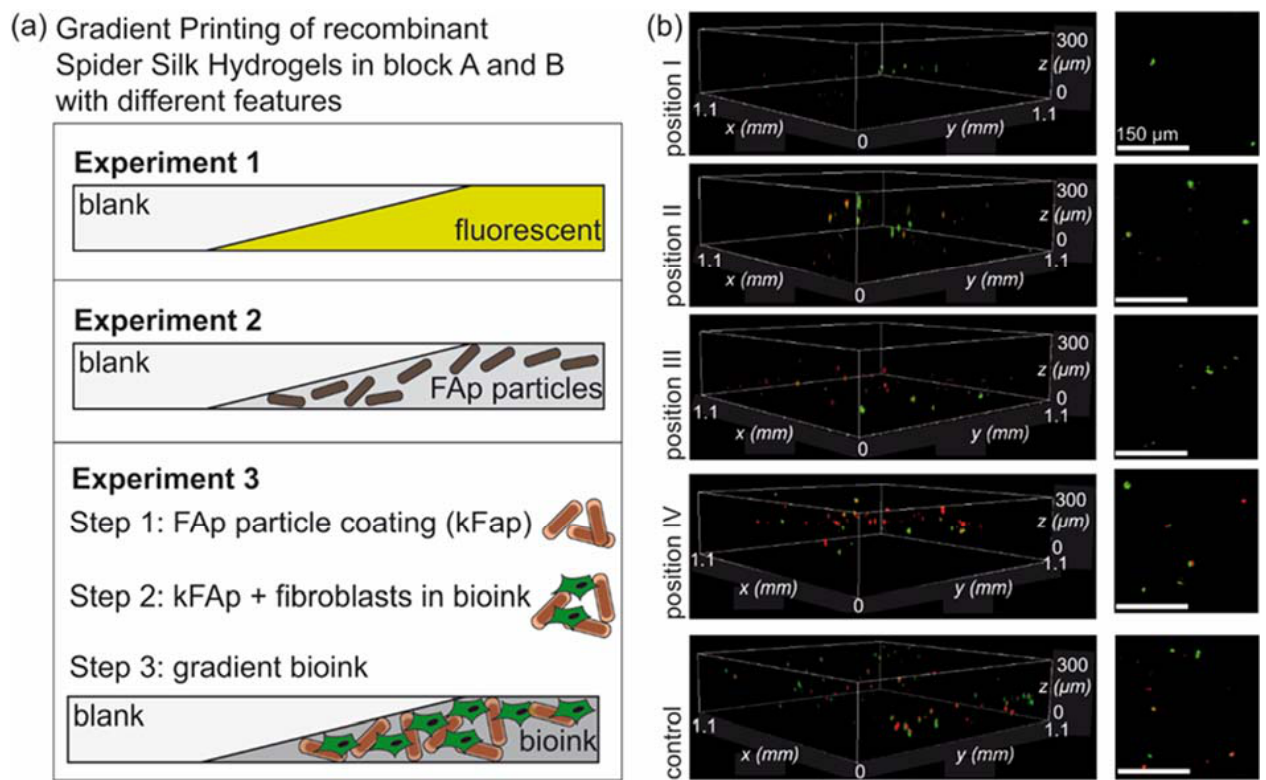
Figure 5. ( a ) Scheme of different experimental set-ups for gradient printing from one printer cartridge with different features. ( b ) Confocal laser scanning microscopy images of fluorescently labeled BALB/3T3 fibroblasts using ethidium homodimer I (red: dead cells)/calcein AM (green: living cells) staining. Cells and 1% w / v κ FAp particles were loaded into a hydrogel and gradient-printed towards an unloaded hydrogel (both hydrogels 3% w / v eADF4(C16)); position I with lowest and position III with highest concentration of cells/particles. Static cell and particle-loaded hydrogels served as control. Left: side view, right: top view. Scale bars right row 150 µ m. κ FAp refers to FAp particles coated with eADF4( κ 16).